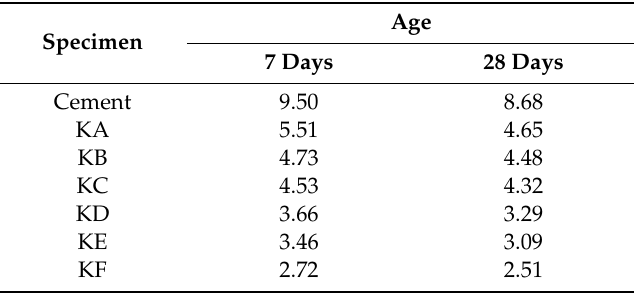
Table 5. Time ranges of the main-array.